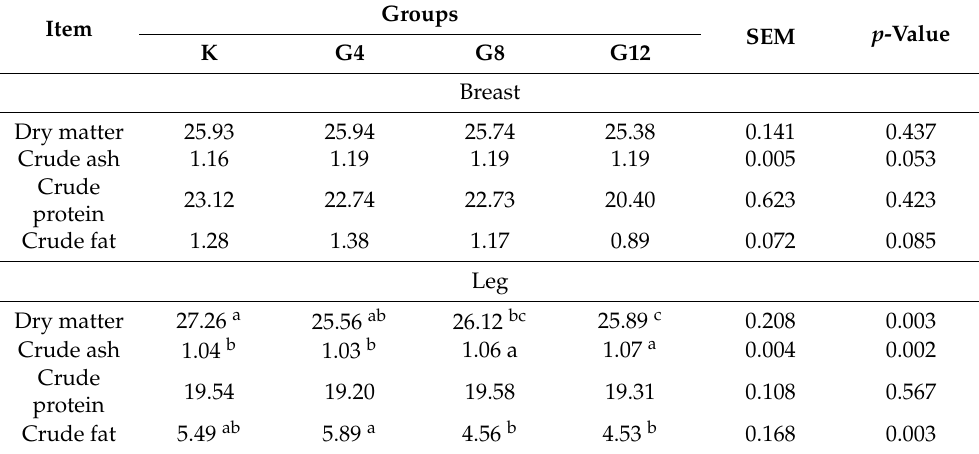
Table 7. Proximate composition (g · 100 g –1 ) in muscles of broiler chickens fed graded levels of guar meal.